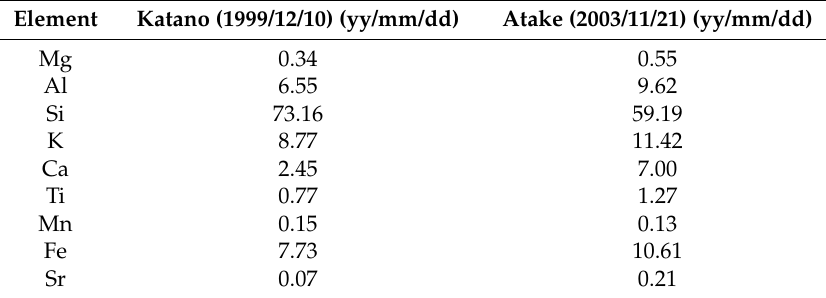
Table A2. Average elemental composition (wt %) of beach sands collected from Katano seashore and Atake seashore analyzed by